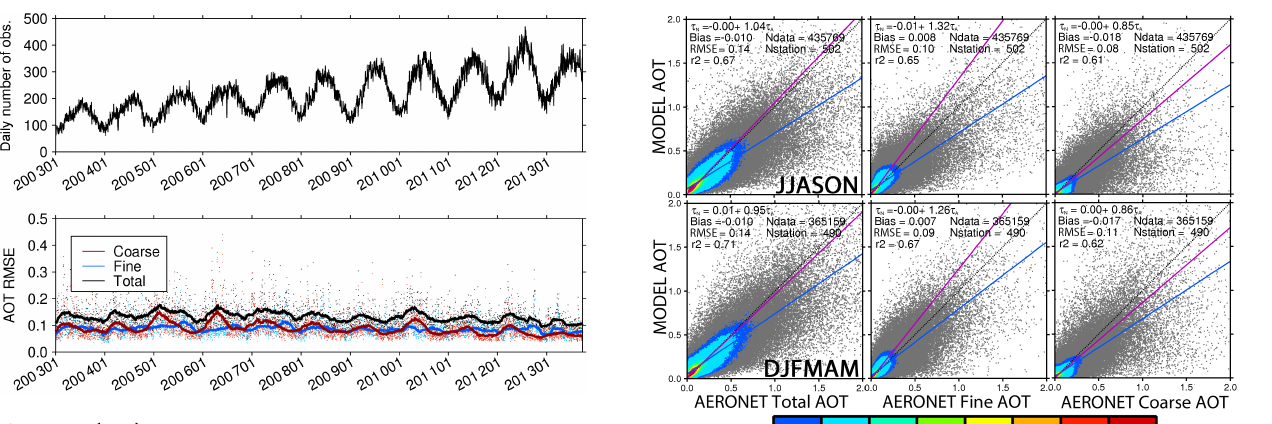
Figure 6. (Top) time series of the daily total number of global regular AERONET L2 observations (excluding observations at DRAGON sites) binned into 6-hourly intervals (to match the model output resolution) for the AOT reanalysis period. (Bottom) time se- ries of the RMSE of the reanalysis total AOT (black), fine-mode AOT (blue) and coarse-mode AOT (red), all at 550nm, validated with AERONET. The daily average 6h RMSEs are in small dots and the corresponding 90-day-running averages are in solid lines.